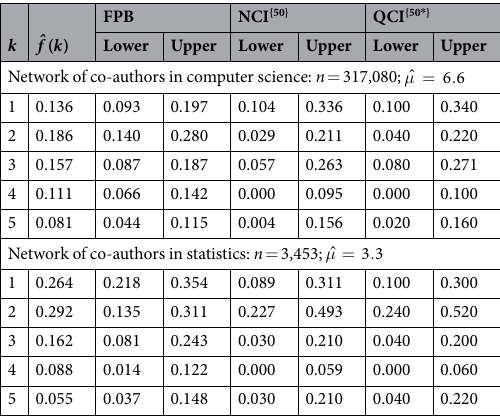
Table 2. The 95% confidence intervals for the population probabilities f ( k ) of two collaboration networks. Methods of obtaining confidence intervals are fast patchwork bootstrap (FPB), normal interval based on estimated proportions and their variance using 50 random nodes (NCI {50} ), and bootstrap of 50 random nodes (QCI {50 * } ). In FPB, 12 seed-wave combinations were considered: waves from 1 to 3, seeds 20, 30, 40, and 50.